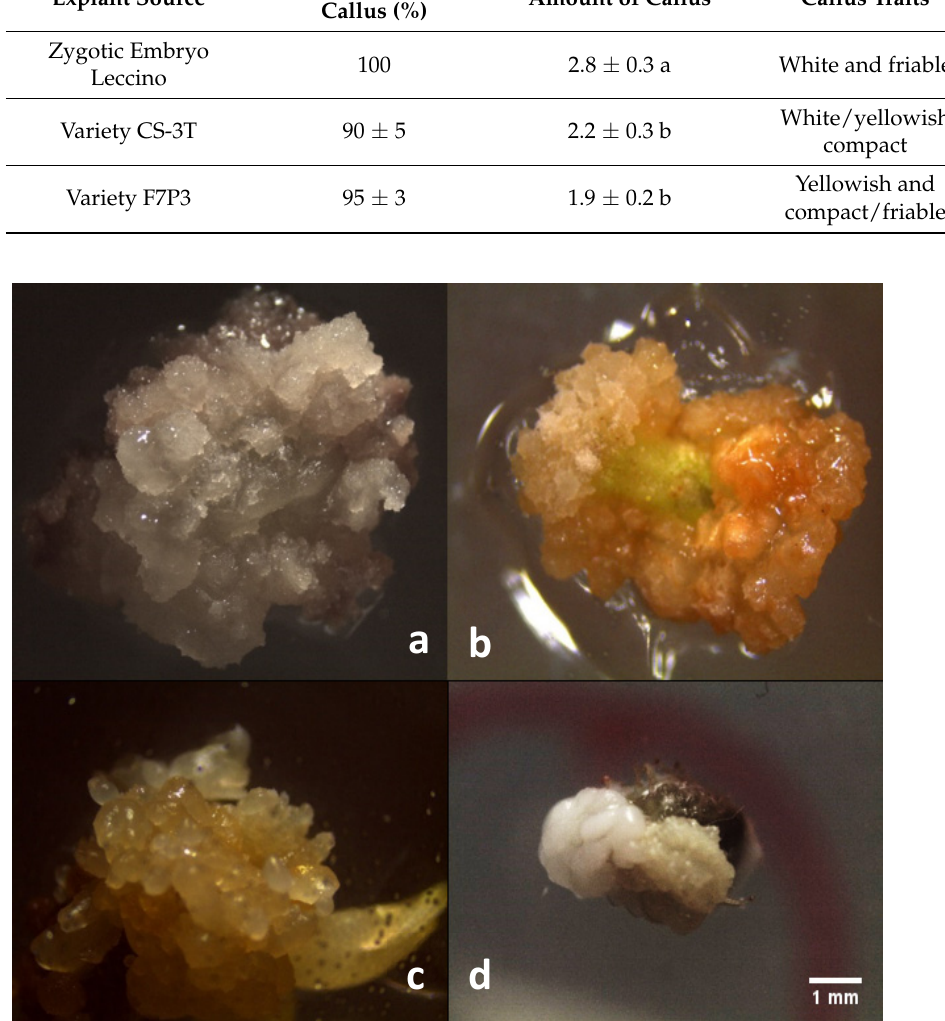
Figure 2. White callus derived from the zygotic embryos of open-pollinated cv. Leccino ( a ) and the yellowish callus derived from the shoot apex of the cultivar CS-3T ( b ). Embryo-like structures in CS-3T ( c ) and the aggregation of well-formed embryos on the callus surface of cultivar F7P3 ( d ). (Scale bar = 1 mm). Table 2. The callus formation of the different explant sources of the immature embryos of cv. Lec- cino, and the leaflets of growing shoots from the varieties CS-3T and F7P3, after 4 weeks on the induction medium. Data are reported as the mean ± standard deviation. The mean denoted by dif- ferent letters are significantly different (Duncan’s test, p < 0.05). The amount of callus formation has been estimated by an arbitrary scale (0 no callus, 1: < 40%, 2: 40–80%, and 3: 80–100%) on visual criteria, as recommended by [15 ].